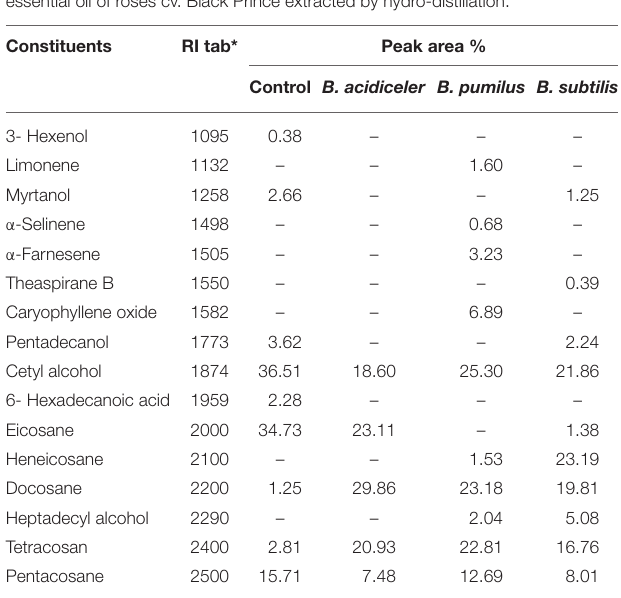
TABLE 6 | Effect of growth-promoting bacteria on chemical composition of essential oil of roses cv. Black Prince extracted by